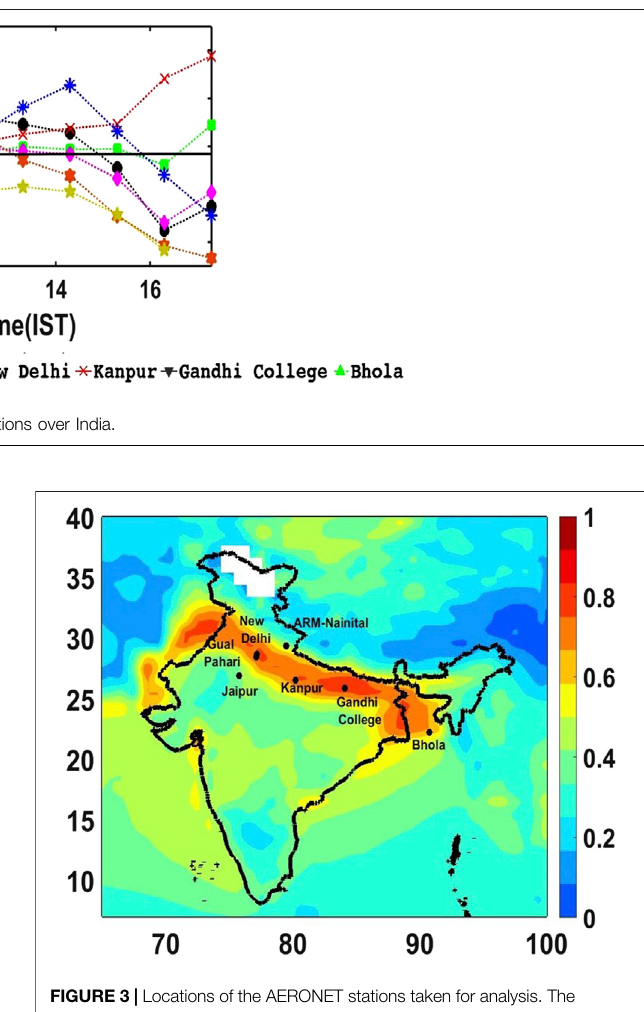
FIGURE 3 | Locations of the AERONET stations taken for analysis. The background shows the annual climatology of aerosol optical depth from 2002 to 2019 from MODIS